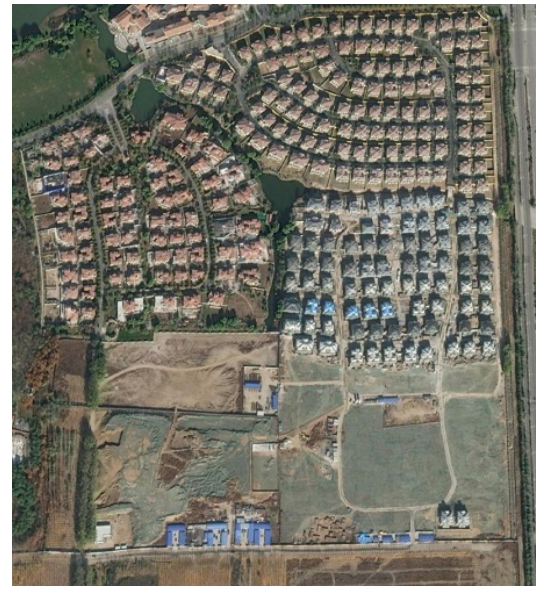
( c ) Data 2: Terra-SAR image acquired in 10 November 2014. ( d ) Data 2: Optical image from Google Earth, acquired in 12 After denoising November 2014 Figure 5. The two time-series dataset of TerraSAR-X remote sensing images in the Tongzhou District of Beijing. ( a ) The 7th scene of the first dataset and the corresponding optical image is shown in ( b ). ( c ) The 10th scene of the second dataset and the closest optical image in time is shown in ( d